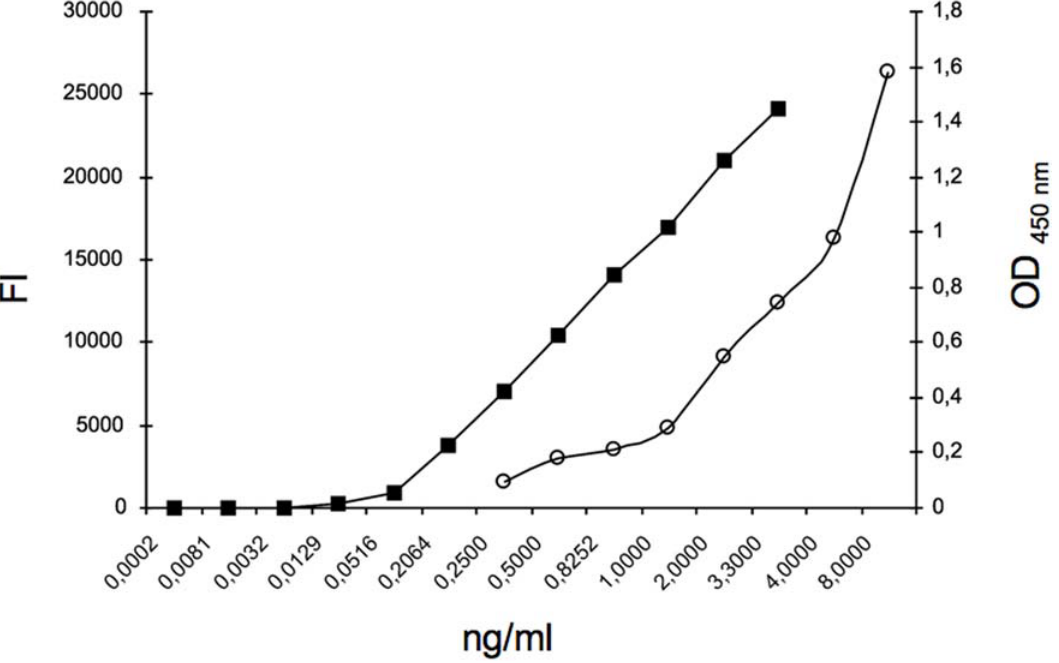
Figure 1. ELISA and Bio-Plex standard curves (white circles and black square respectively) have been obtained with 50 m l of ICAM-1 standard reagent at the concentrations of 0.25, 0.5, 1, 2, 4, 8 ng/ml or 0.0002, 0.00081, 0.0032, 0.0129, 0.0516, 0.20638, 0.82522, 3.3 ng/ml as indicated. FI: fluorescence intensity values. OD 450 nm: optic density at 450 nm wavelength.